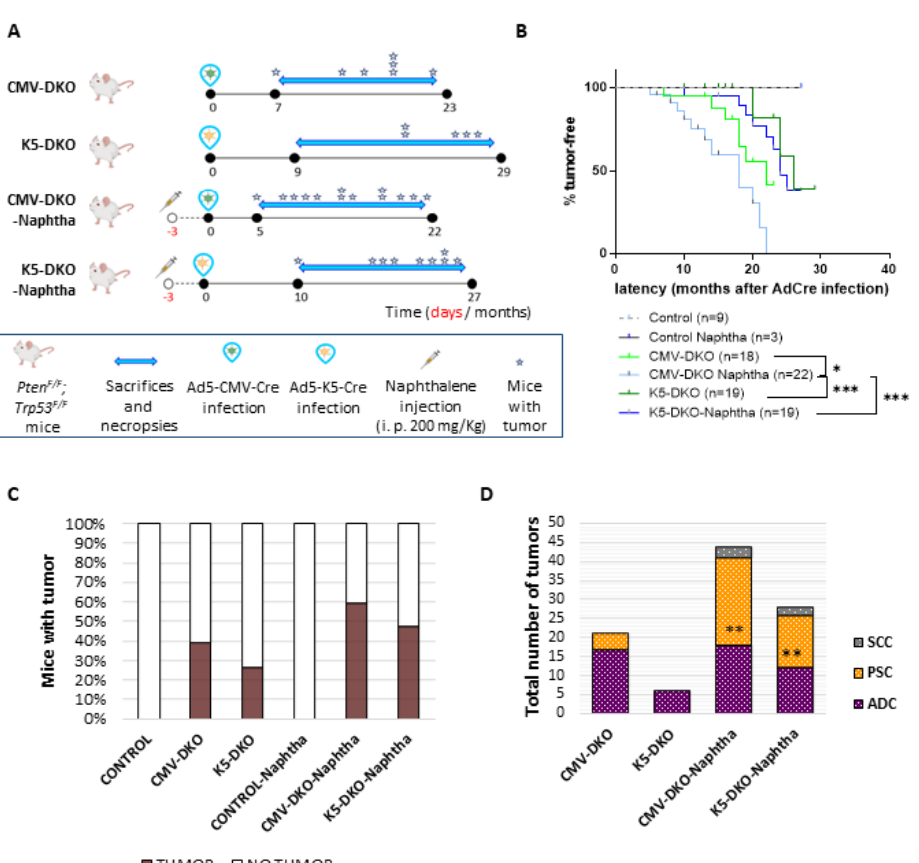
Figure 1. Combined deletion of Pten and p53 in adult lungs. ( A ) Schematic of the mouse model experiment. Time course of naphthalene administration, adenovirus injection and mouse necropsy.